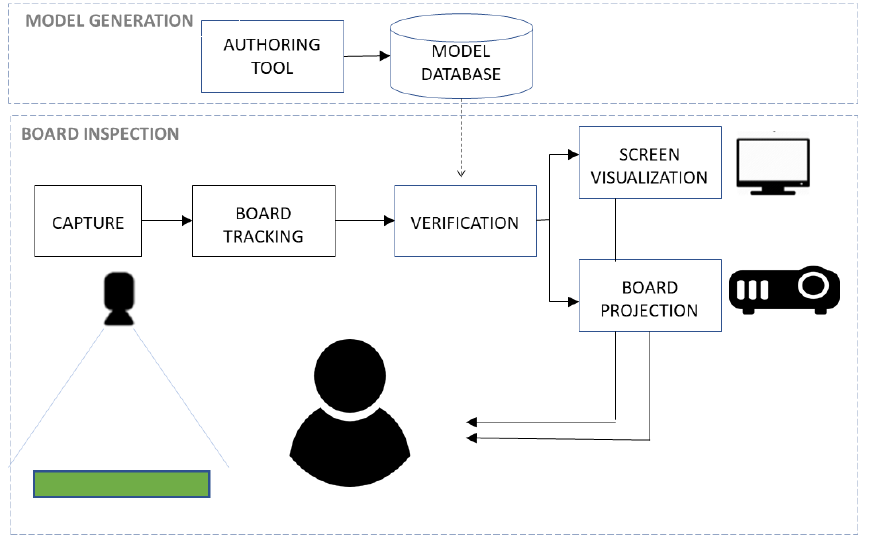
Figure 1. Pipeline of the